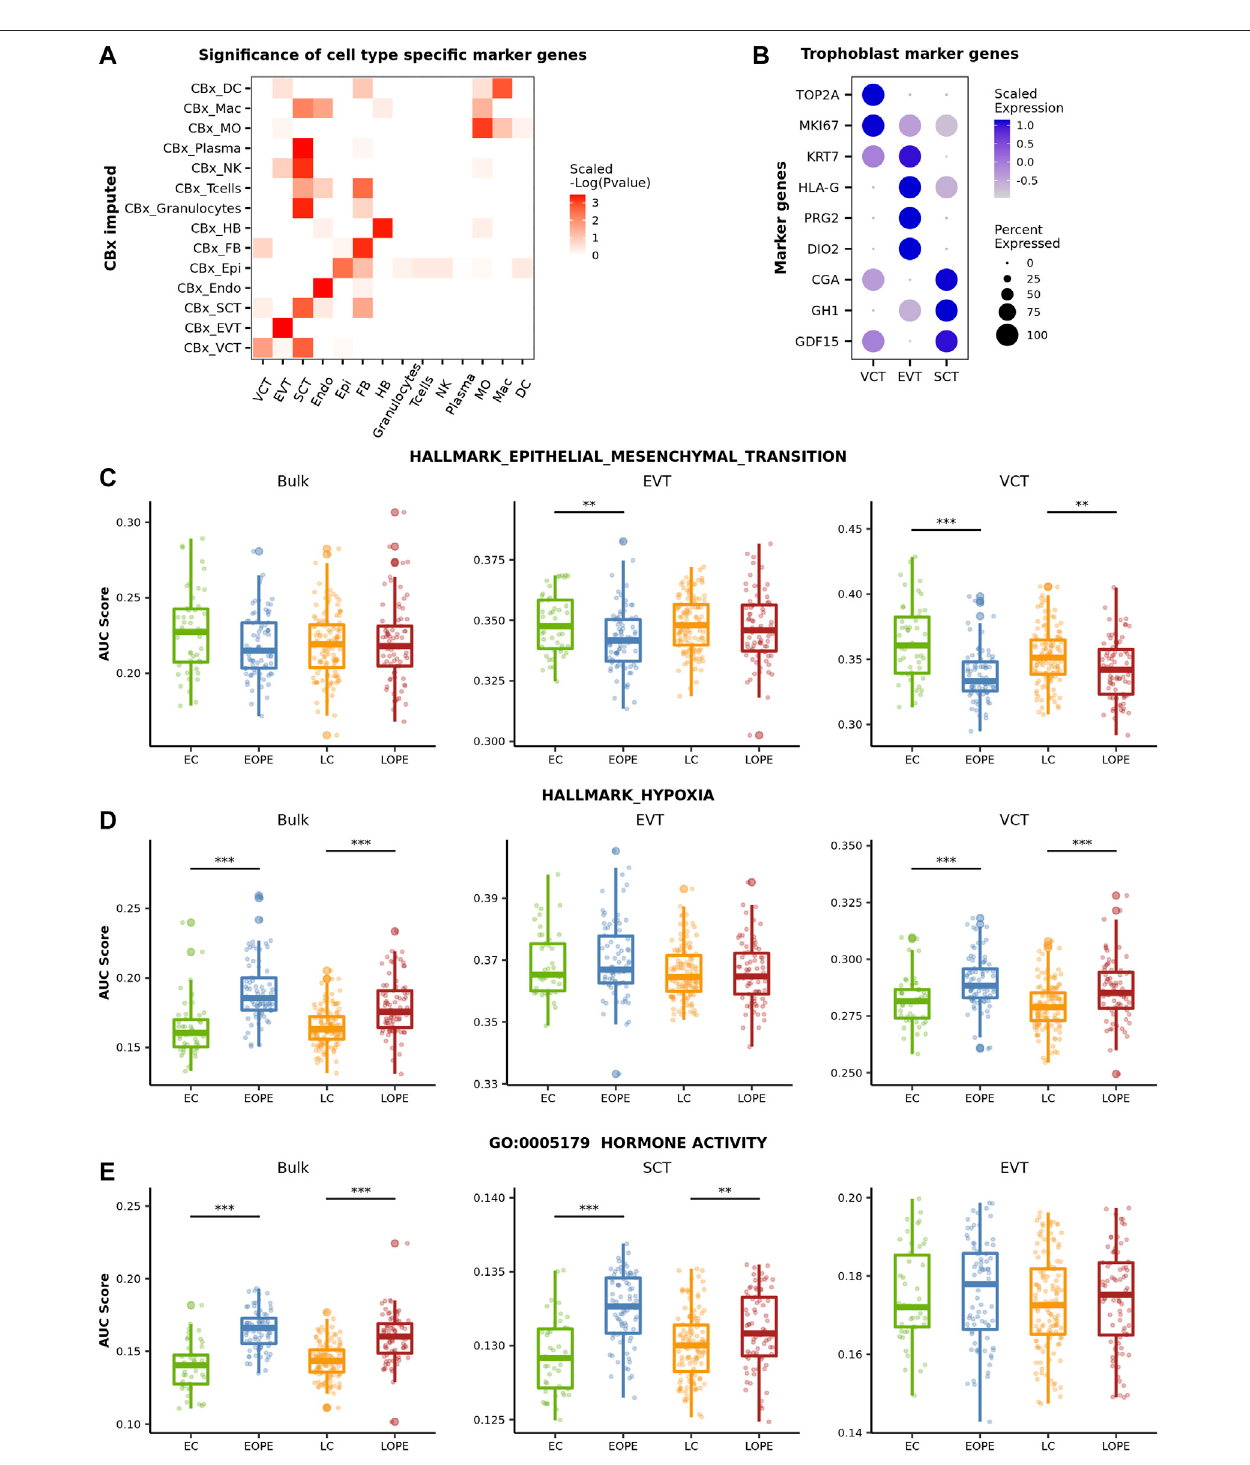
FIGURE 3 | Comparison of the activity of canonical PE-related pathways in between PE and normal samples. (A) Assessment of the biological relevance of the predicted cell-type-level expression pro fi les. We fi rst averaged the expression pro fi le of imputed transcriptome in each cell type. Then, the Wilcox test was used to evaluate if the expression on the averaged pro fi le of the cell-type marker genes is speci fi cally high in the corresponding cell type. The negative log P value of the Wilcox test was scaled by rows. (B) The expression level of classic trophoblasts marker genes in the predicted cell-type-level expression pro fi les of three trophoblast subtypes. (C – E) Activity of the canonical PE-related pathway in different groups of samples. The activity was measured by AUCell.